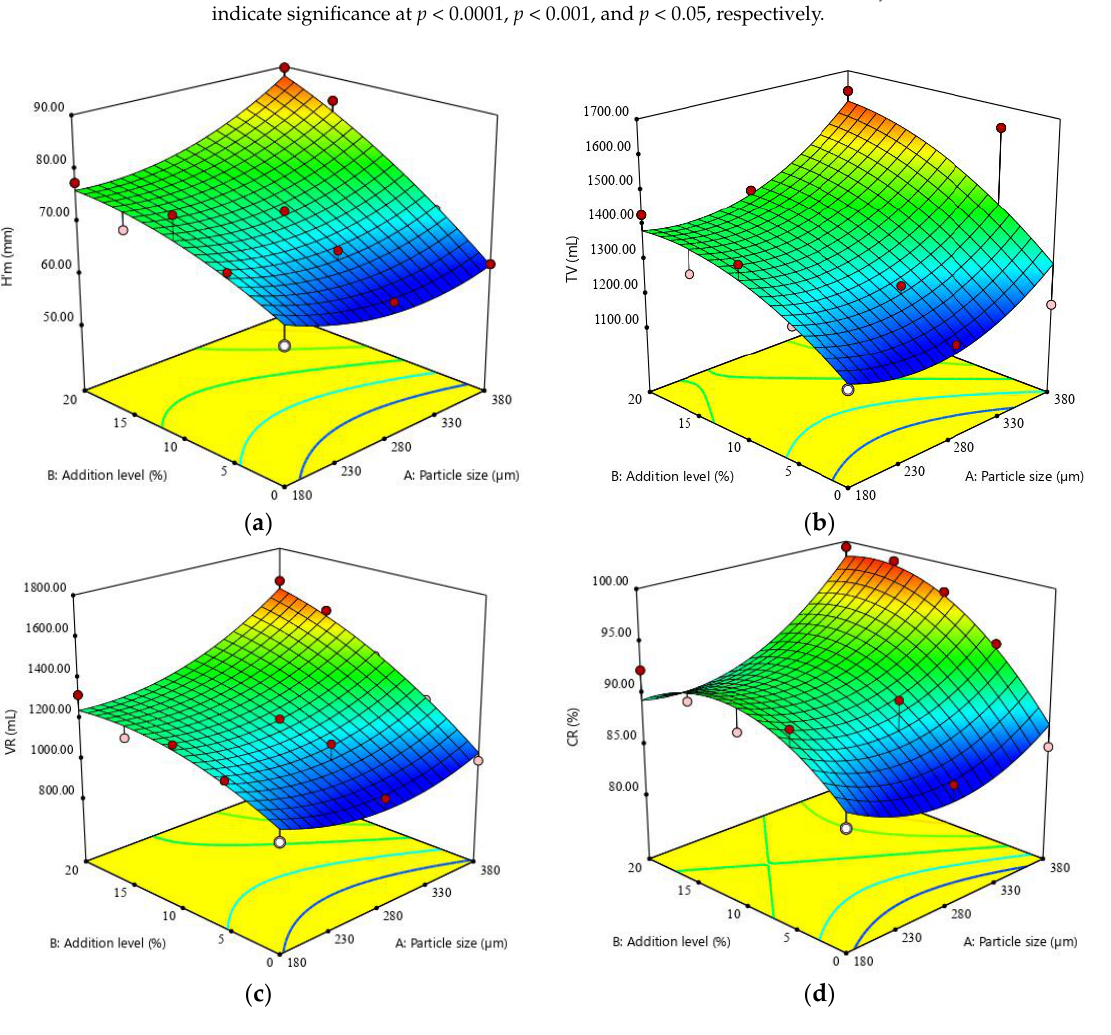
Figure 4. Response surface graphic of ( a ) maximum height of the gas release curve (H’m), ( b ) total volume of gas produced (TV), ( c ) volume of gas retained in the dough (VR), and ( d ) retention coefficient (CR) as a function of buckwheat flour fractions and addition level.